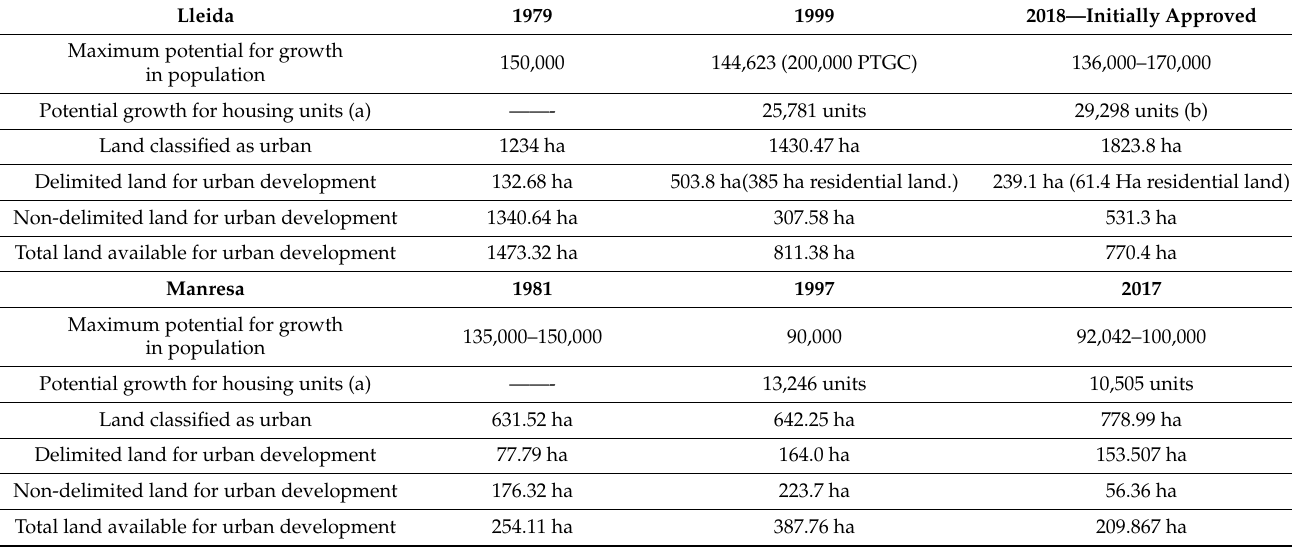
Table 2. Potential for growth, housing, and land classification in the different Master Plans for Lleida and Manresa [40].